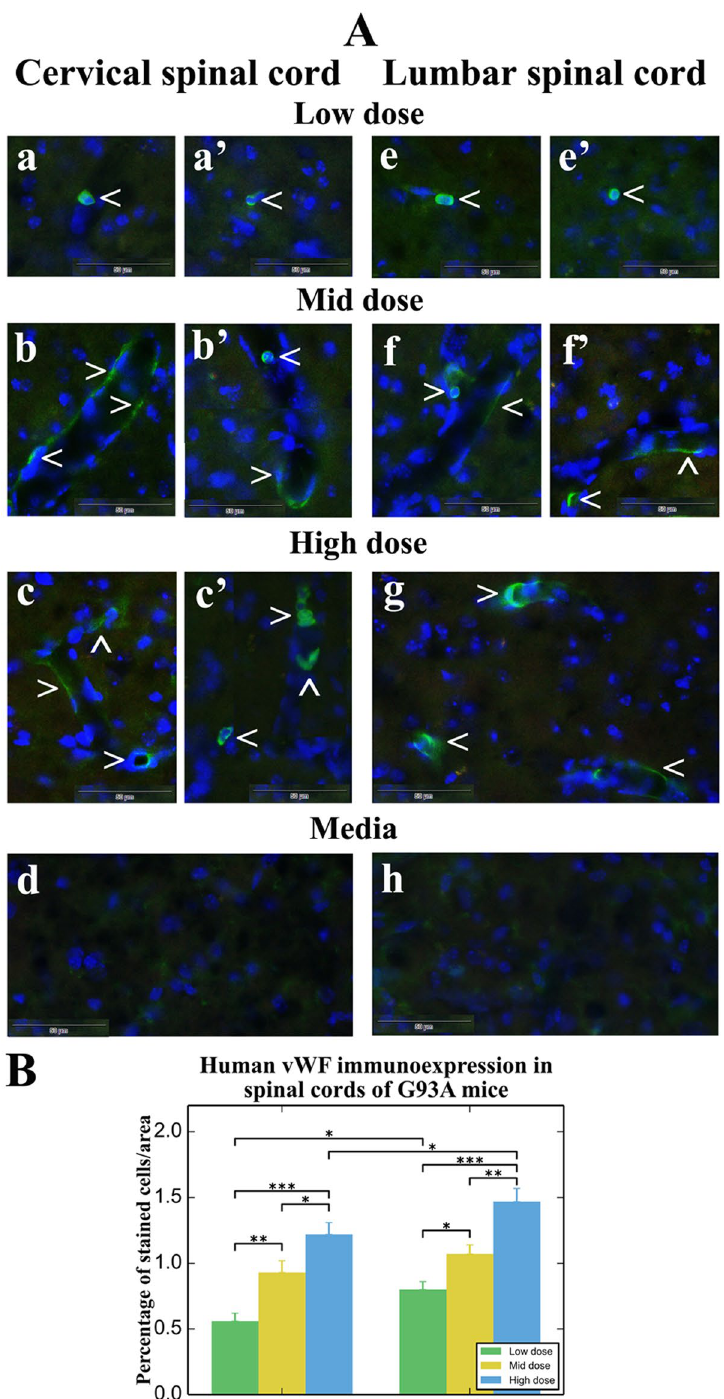
Figure 2. Immunohistochemical staining for human vWF in the cervical and lumbar spinal cords of G93A mice receiving different cell doses. ( A ) Immunopositive vWF expression (green, arrowhead) was indicated in cells with rounded or oval shapes within capillaries of the cervical (a,a’) and lumbar (e,e’) spinal cords of mice receiving the low cell dose. Adherent transplanted cells expressing vWF in lumen of microvessels formed a distinguishable lining in capillary walls (green, arrowhead) in the cervical (b, b’) and lumbar (f,f’) spinal cords of mice with mid cell dose. Numerous capillaries in the cervical (c,c’) and lumbar (g) spinal cords of mice treated with high cell dose showed immunopositive vWF expression (green, arrowhead) indicating impressive amounts of transplanted cells adhering to vascular walls. No immunoexpression of vWF was found in the spinal cords of media-injected mice (d,h). Images are merged with DAPI. Scale bar in a-h is 50 µ m. ( B ) Quantitative analysis of fluorescent vWF expression in ventral gray matter of the cervical and lumbar spinal cords showed significant dose-dependent increases in fluorescent expression of vWF. * p < 0.05, ** p < 0.01, *** p <